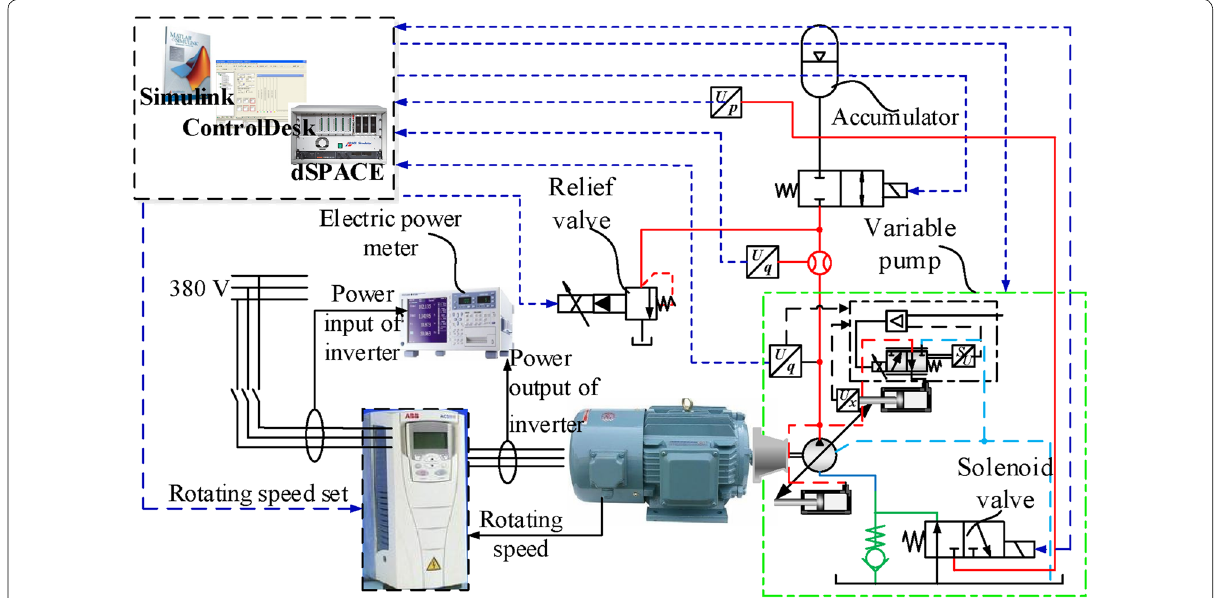
Figure 2 Test system of the electro-hydraulic power